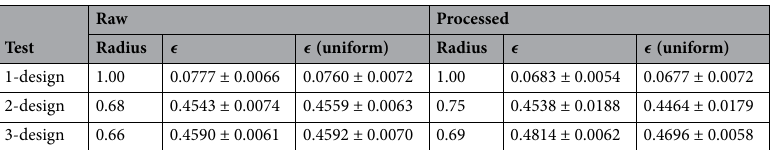
Table 3. Summary of test results for the ensemble of unitaries generated using the ibmq_toronto quantum processor. ‘Raw’ shows the results without quantum readout error mitigation. ‘Processed’ shows the results with quantum readout error mitigation. ‘Radius’ is the truncation radius considered for a test. The column with ‘uniform’ shows the values of ǫ obtained when replacing the experimentally determined relative frequencies with uniform probabilities.